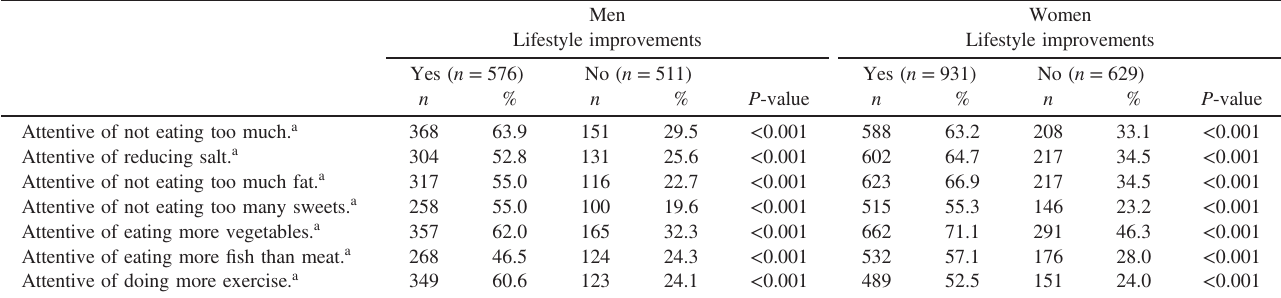
Table 3. Attention to heathy behaviors among participants who were practicing lifestyle improvements with the intention of preventing CVDs “ Yes ” or “ No ” : NIPPON DATA2010 Men Women Lifestyle improvements Lifestyle improvements